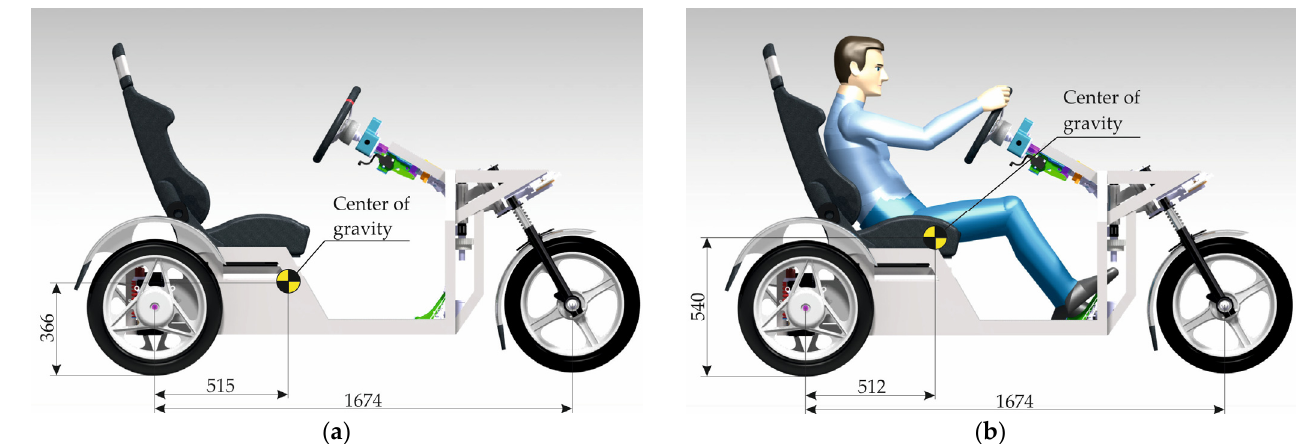
( b ) Figure 10. A calculation schema of the E3-cycle: ( a ) Back view; ( b ) Top view.